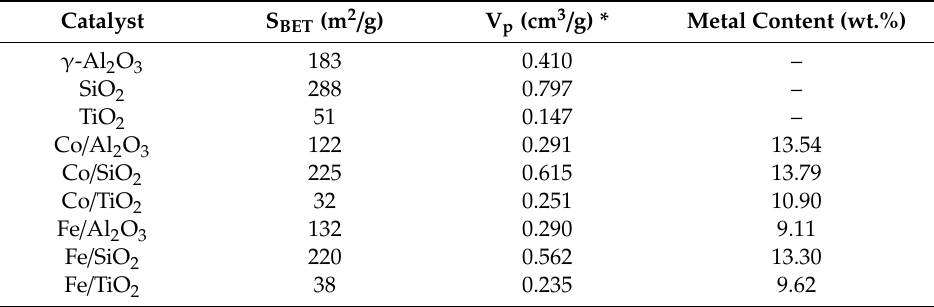
* Total pore volume, calculated from N 2 adsorption at p / p o =